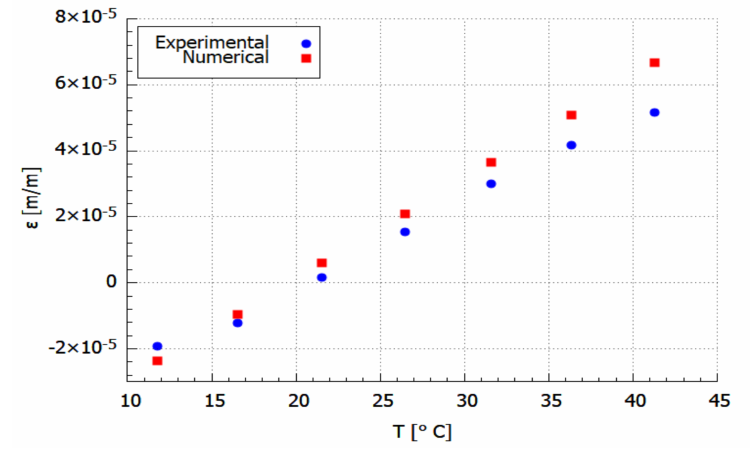
Figure 6. Discrete comparison of experimental and numerical results.